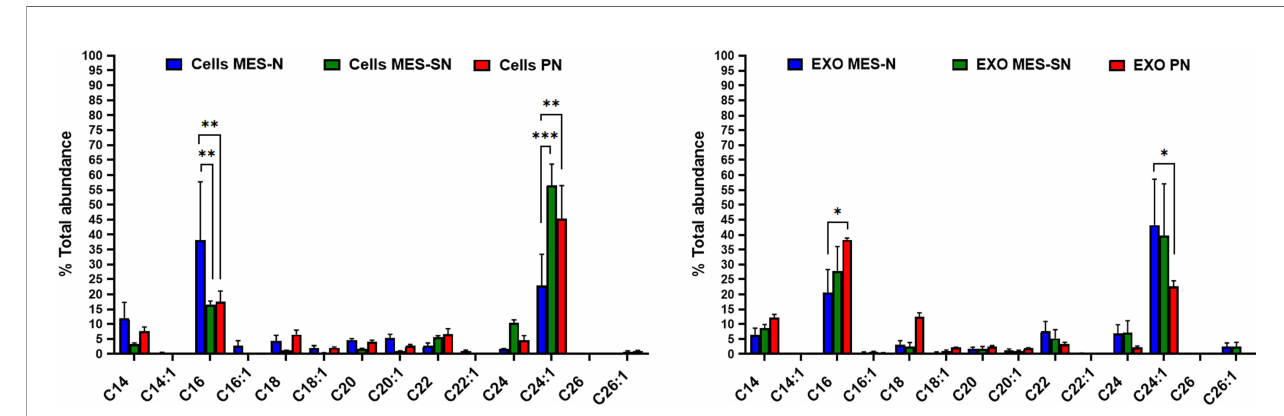
FIGURE 5 | Normalized ceramide pro fi les among the three phenotypes in cells and exosomes. In blue, MES-N phenotype; in green, MES-SN phenotype; and in red, PN phenotype. For all bar graphs, error bars represent mean ± SEM. *p < 0.05; **p < 0.01; and ***p < 0.001.